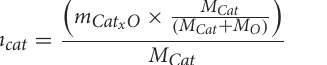
Duration Temp Total flow-run (days) ( ◦ C) through volume